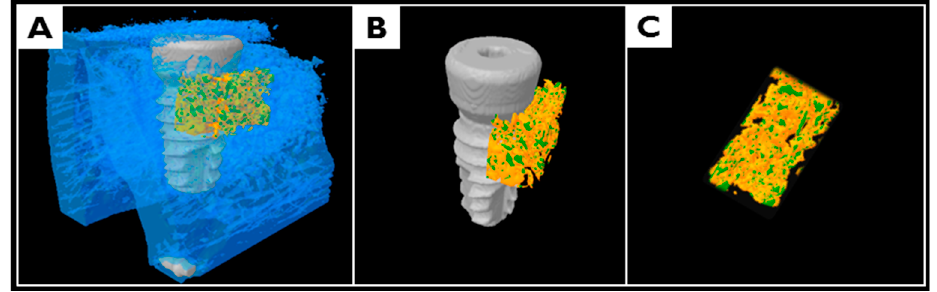
Figure 13. 3D images obtained by micro-computed tomography ( μ CT); ( A ) mandibular block section around a peri-implant; ( B ) new bone in a peri-implant without the old bone; and ( C ) new bone of region of interest (ROI).